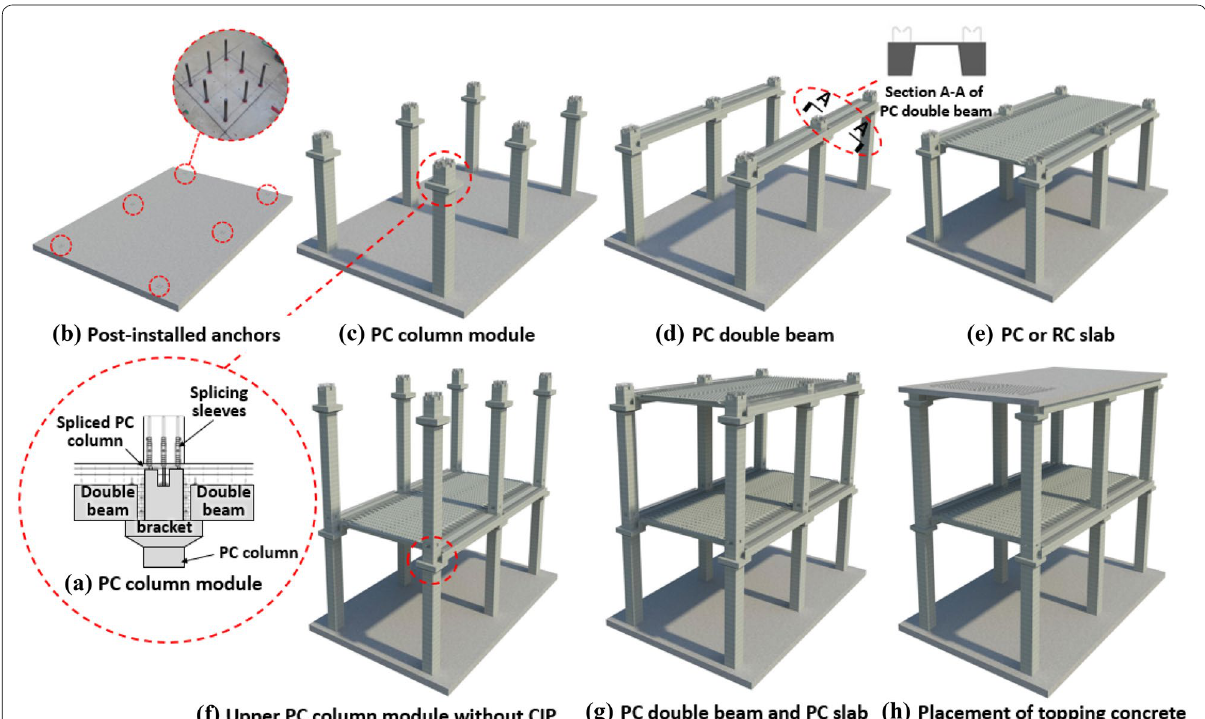
Fig. 3 Construction of PC double beam–PC column